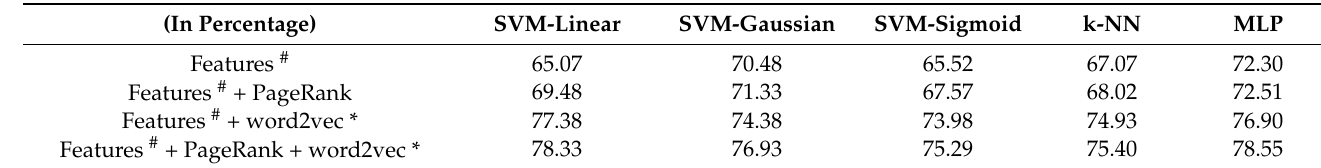
Table 8. Model accuracy by traditional learning approach.